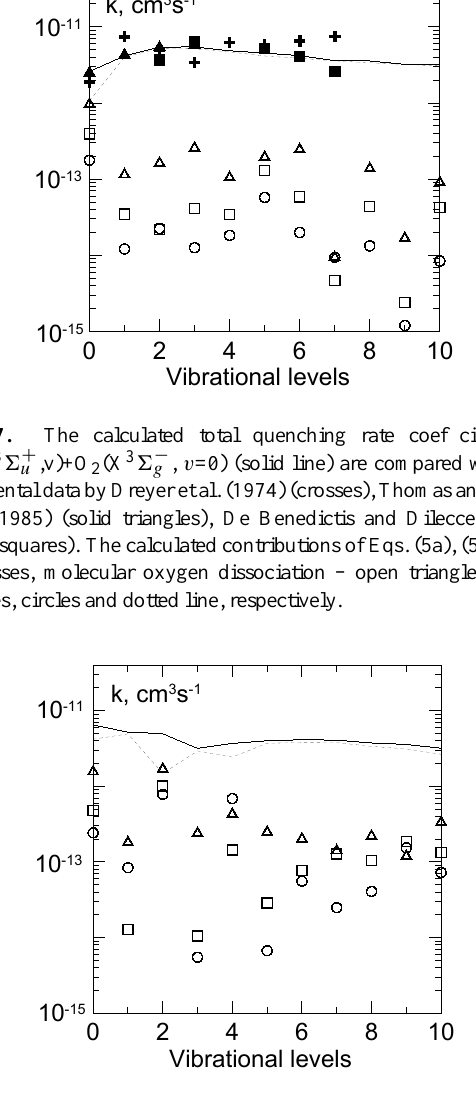
Fig. 8. The same as in Fig. 7, but for the vibrational level v =1 of O 2 (X 3 6 − g ) Figure 8. The same as in Fig.7, but for the vibrational level v=1 of O 2 (X 3 Σ g– ).